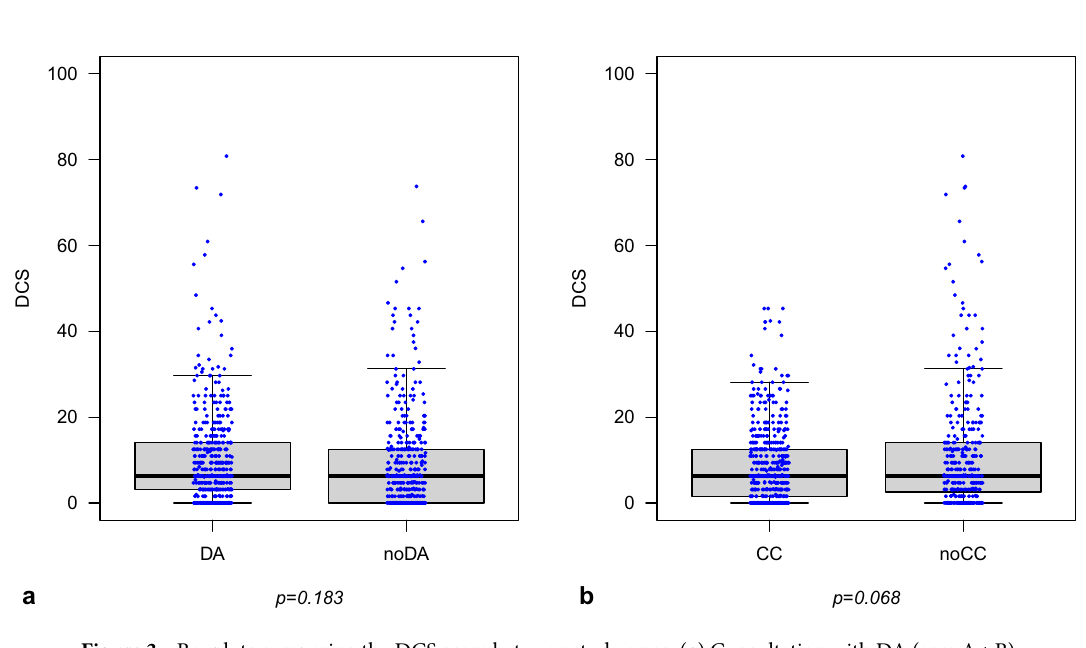
Figure 3. Boxplots comparing the DCS score between study arms. ( a ) Consultation with DA (arm A + B): Q25% = 3.1; Median = 6.2; Q75% = 14.1 vs. consultation without DA = noDA: Q25% = 0; Median = 6.2; Q75% = 12.5. ( b ) Consultation with cost compensation CC (arm A + C): Q25% = 1.6; Median = 6.2; Q75% = 12.5 vs. without cost compensation = noCC (arm B + D): Q25% = 2.5; Median = 6.2; Q75% = 14.1. DCS = decisional conflict scale: 0–100; higher values indicate greater decisional